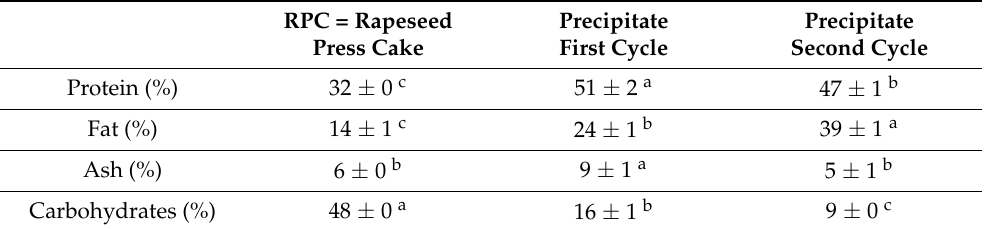
Table 2. Proximate analysis on dry basis of the rapeseed press cake and the precipitate from the first and second cycle. Different letters indicate significant differences, p ≤ 0.05. RPC = Rapeseed Precipitate Press Cake